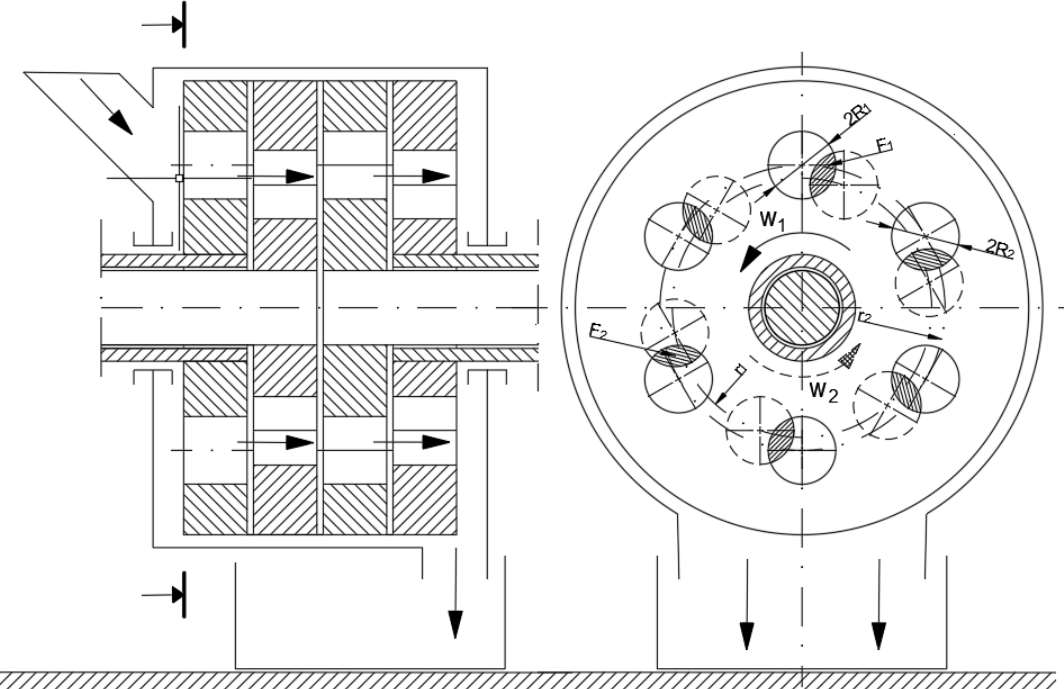
Figure 18. Diagram of the material flow in a multi-disc grinder with determination of the effective grinding areas [106].